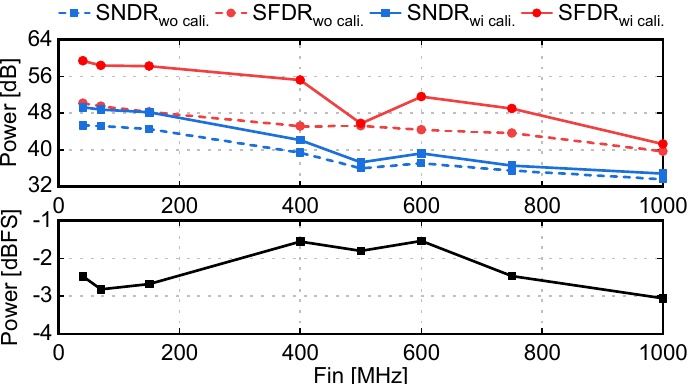
Figure 15. Measured dynamic performance versus input frequency @ 2.0 GS/s and associated input power.